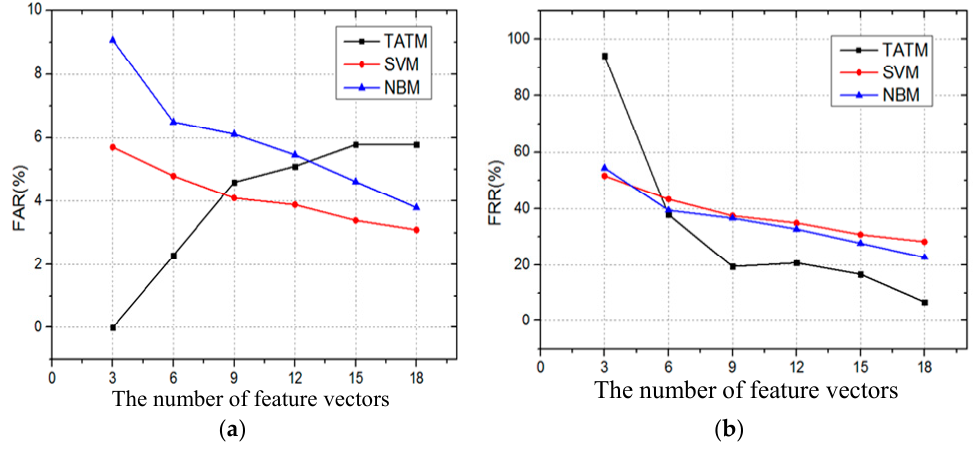
Figure 12. The influence of the number of feature vectors: ( a ) FAR; and ( b ) FRR.